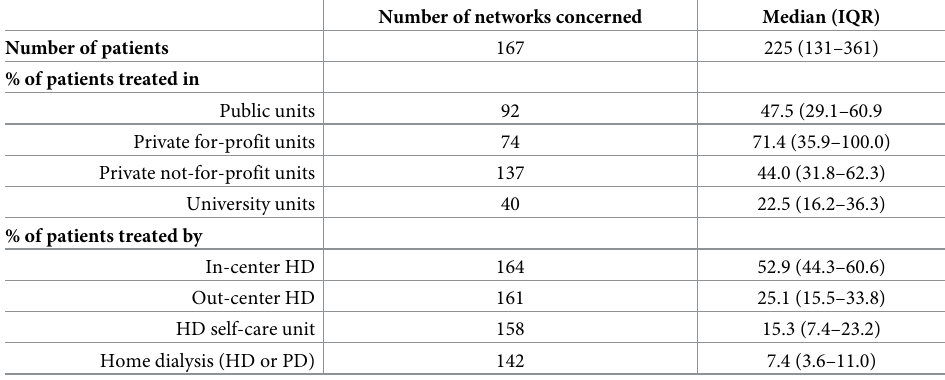
Table 2. Description of the networks (Fast Greedy